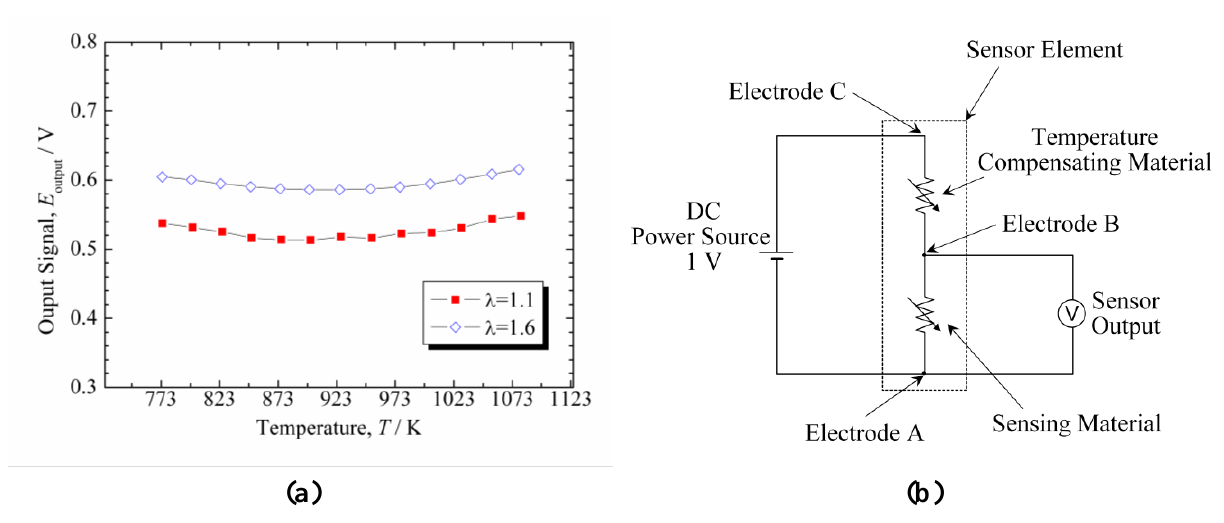
Figure 9. (a) Electrical circuit for the sensor element using the temperature compensating material. (b) Output signal of the sensor element obtained using the electric circuit shown in (a). From